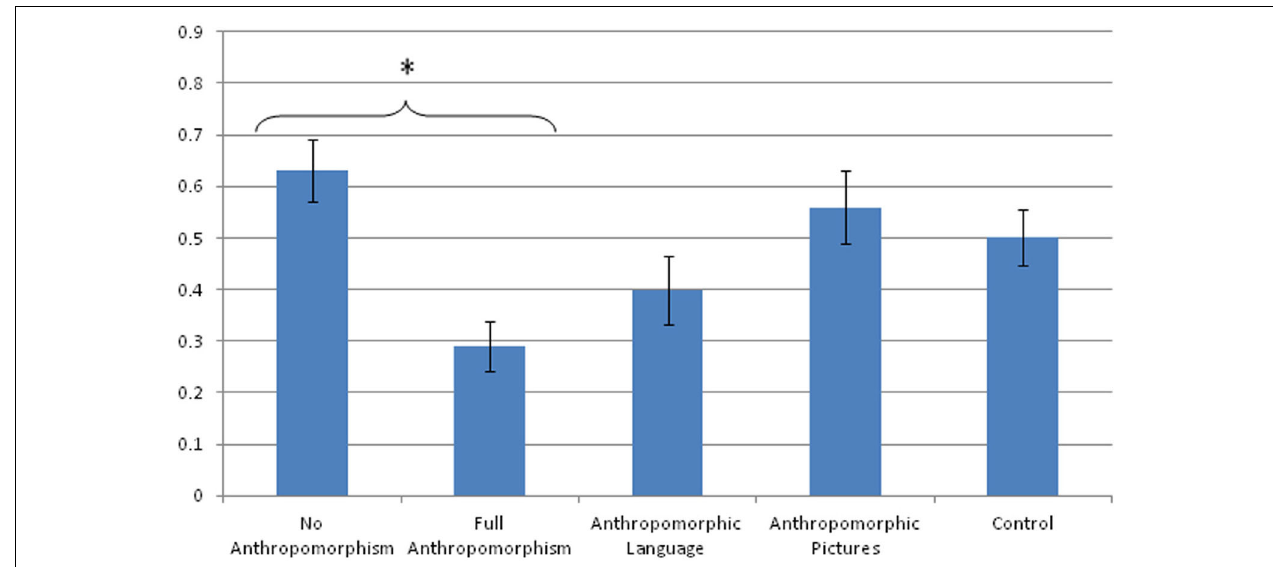
FIGURE 2 | Mean proportions of 5-year-olds’ correct responses to the anthropomorphic questions across all conditions. ∗ p < 0 .